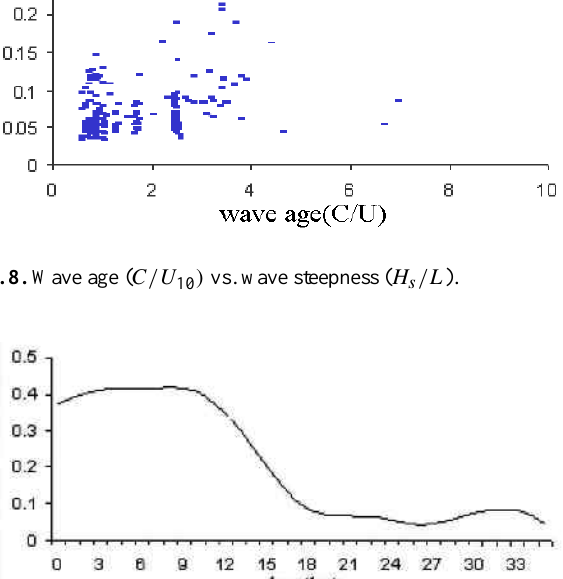
Figure9. Variation of cross- correlation for wind speed (U10) and significant wave height (Hs) with time-lag Figure10. Wind speed partial auto correlation with 1hr time lag